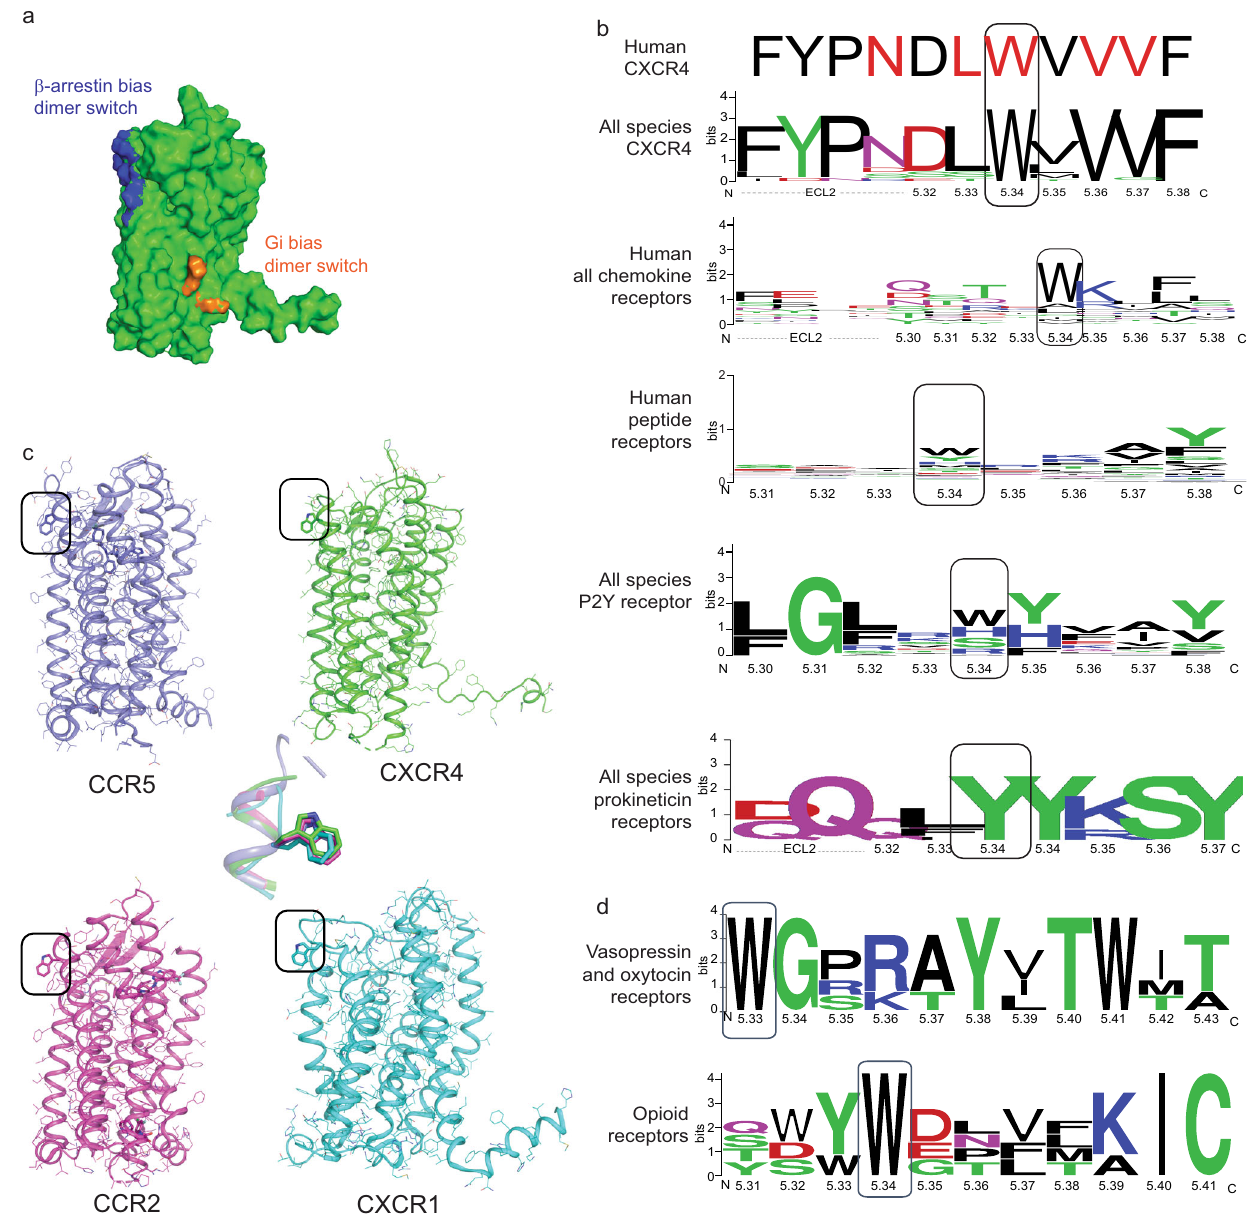
Fig. 5 | Distinct quaternary structures selectively control G protein and β - arrestin recruitment. a Surface representation of the CXCR4 inactive state mono- mericstructurehighlightingthedistinctoligomerizationinterfacescontrollingeither β -arrestinrecruitment(extracellularsideandTMcoreofTMH5,blue)orGiactivation and nanocluster formation 23 (intracellular side of TMH6, orange). b The hotspot binding sites controlling CXCR4 oligomerization through TMH5 (designed residues